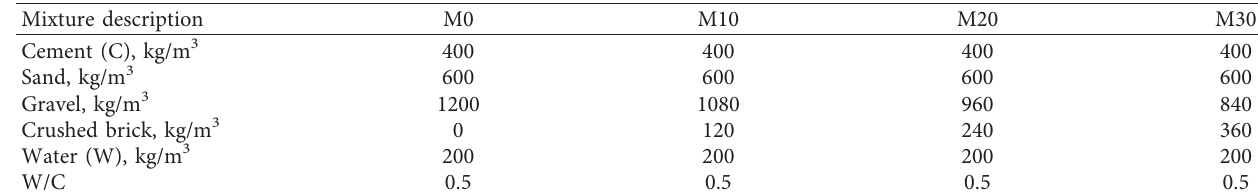
Figure 1: Crushed bricks sample. Table 1: Mix proportions of concrete mixes.